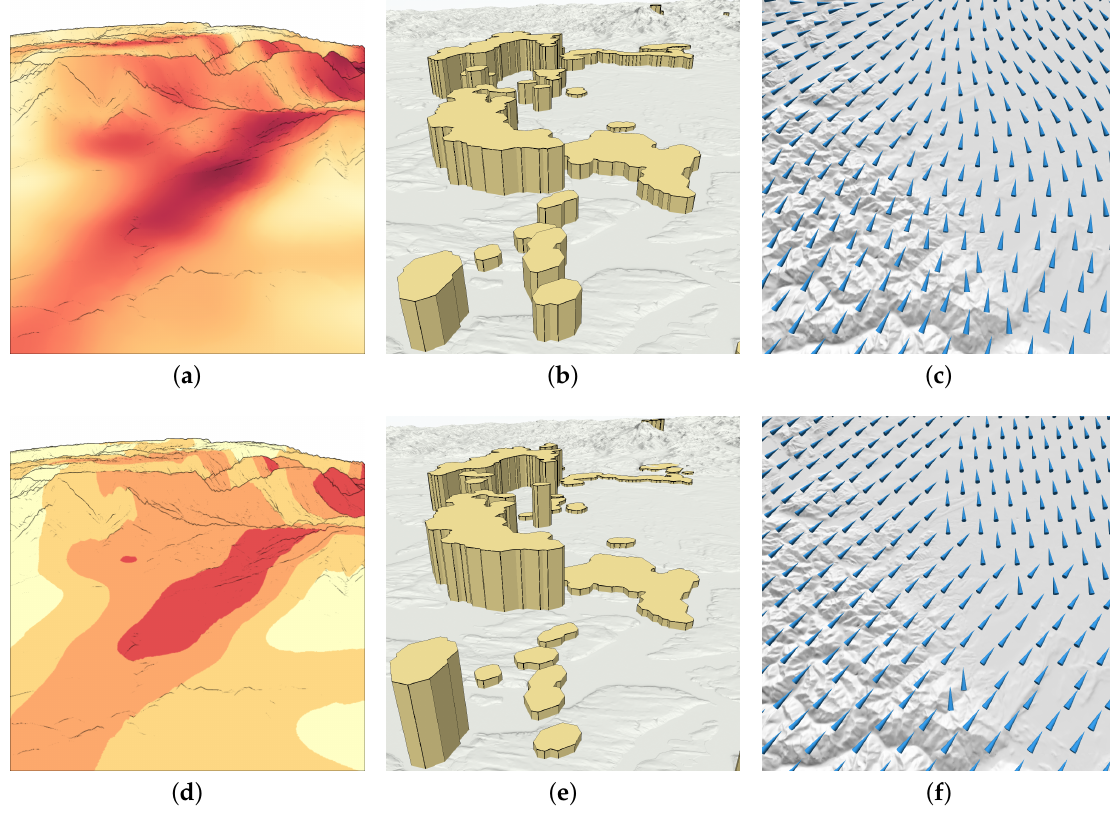
Figure 8. Showing either individual data values ( a – c ) or aggregations ( d – f ) by visual encodings based on color ( a , d ), size ( b , e ), and direction ( c , f